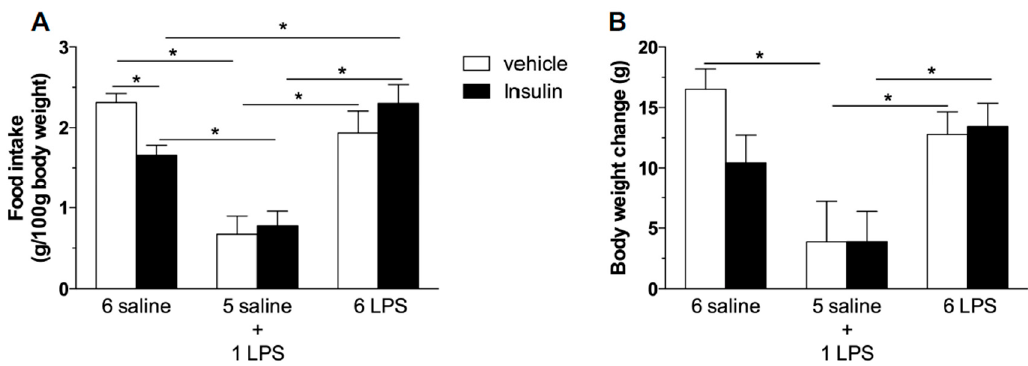
Figure 3. Prolonged endotoxemia induces resistance to the hypophagic effect of icv insulin treatment. Effect of icv injection of vehicle (saline, 5 µ L) or insulin (12 µ M in 5 µ L) on food intake ( A ) and body weight gain ( B ) in saline (6 saline), single (5 saline + 1 LPS, 100 ug/kg ip), or repeated LPS (6 LPS) treated-animals (6–8 animals per group). The representative results of two independent experiments ( n = 6–8/group) are shown. Two-way ANOVA, followed by the Fisher post hoc test were performed. Data are expressed as means ± SE. Differences were accepted as significant at * p < 0.05.